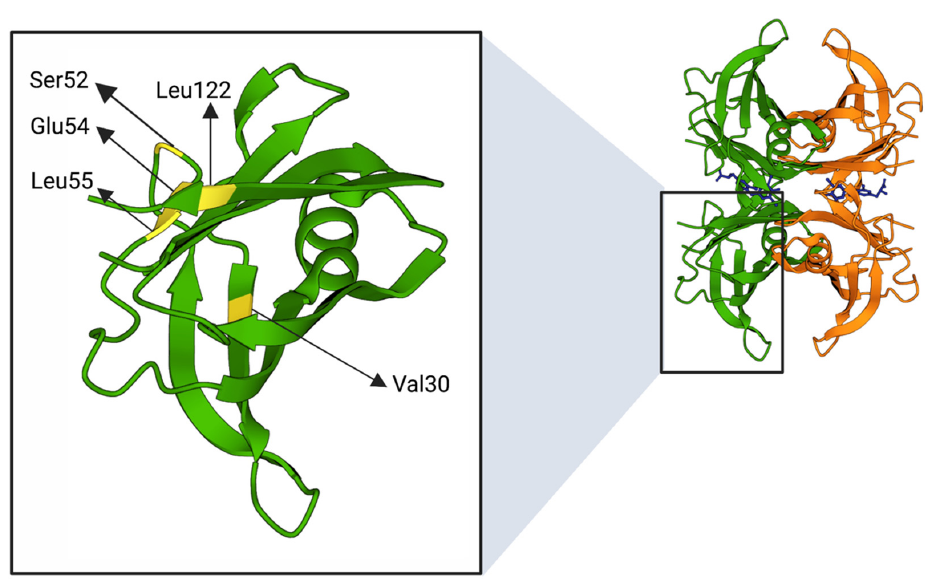
Figure 4. Positions of amino acids (highlighted in yellow) subjected to mutations described in table 1. The fi gure was created through “www.rcsb.org” and “biorender.com” web sites (license agreement number KJ247URGZS), access date 22 June